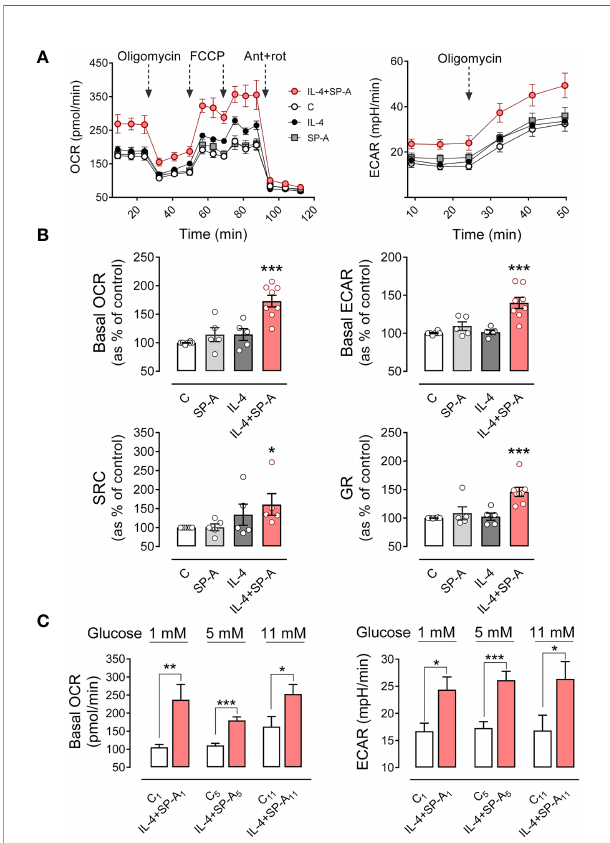
FIGURE 7 | SP-A and IL-4 synergistically increase mitochondrial respiration and glycolysis in AMs. The effect of IL-4 (1 m g/ml) and/or SP-A (100 m g/ml) on the oxygen consumption rate (OCR) and the extracellular acidi fi cation rate (ECAR) in AM cultures was measured using Seahorse XFe24. (A) (left) Alveolar macrophages were treated sequentially with 1 m M oligomycin (ATP synthase inhibitor), 1 m M FCCP (uncoupler of oxidative phosphorylation in mitochondria), and 1 m M rotenone/1 m M antimycin A (inhibitors of mitochondrial complex I and III, respectively) to measure OCR under basal conditions and under mitochondrial stress. (Right) Glycolysis, measured as ECAR, in basal conditions and with oligomycin treatment to evaluate glycolysis intensi fi cation in response to mitochondrial inhibition. (B) Bar graphs to quantify the effect of IL-4 and/or SP-A on (left) basal OCR and spare respiratory capacity and (right) basal ECAR and glycolytic reserve (increase of ECAR after oligomycin addition). (C) Effect of glucose concentration in the culture medium on basal mitochondrial respiration and glycolysis induced by IL-4+SP-A. Data are mean ± SEM from fi ve to eight independent experiments with three to fi ve biological replicates. ANOVA followed by the Bonferroni multiple-comparison test (A, B) or Student ’ s t-test (C) was used. * p < 0.05, ** p < 0.01, and *** p < 0.001 when compared with untreated